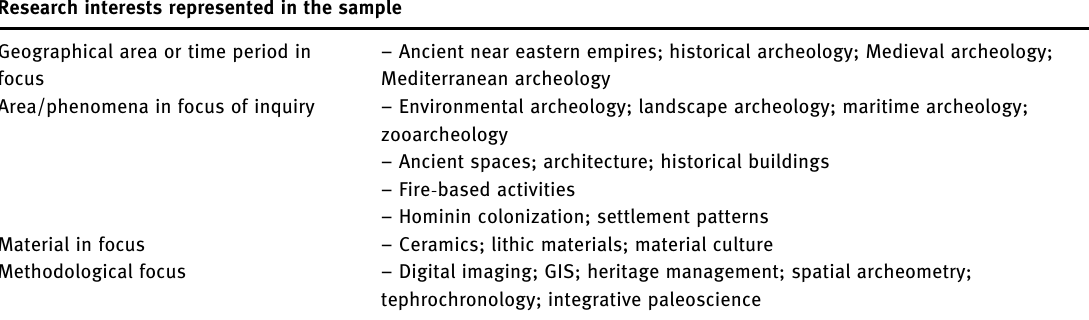
Table 1: Research interests represented in the sample, thematic overview Research interests represented in the sample